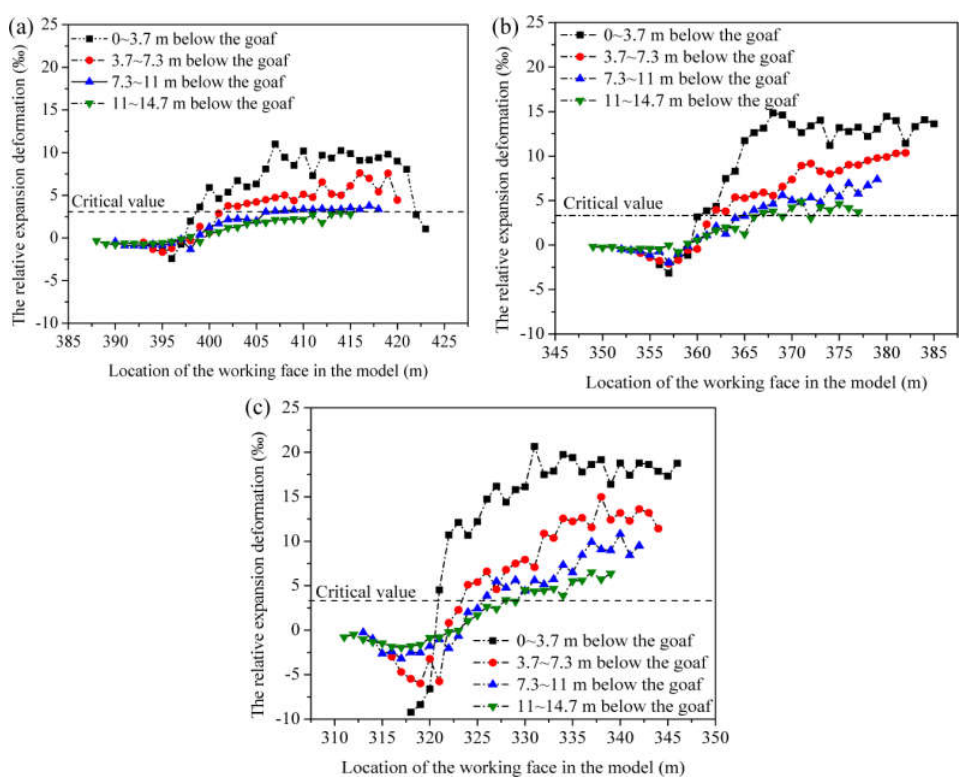
Figure 11. The relative expansion deformation calculation results: ( a ) the 5th slice, ( b ) the 10th slice and ( c ) the 15th slice.